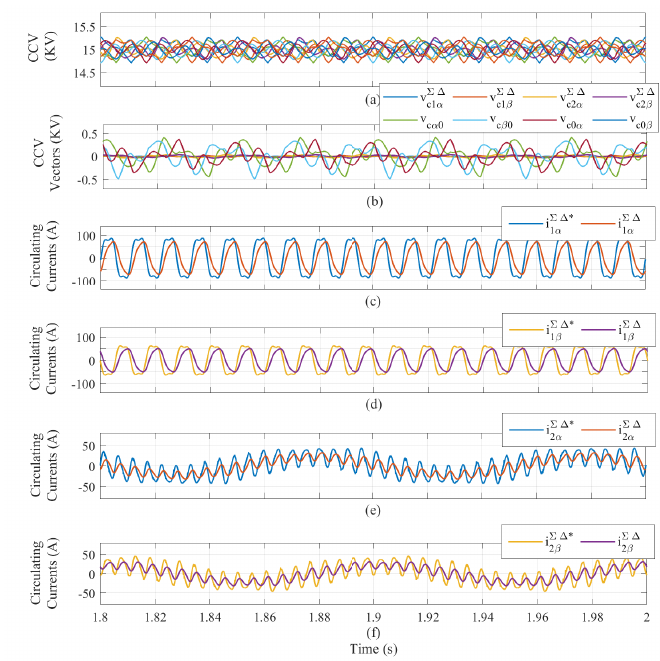
Figure 10. Test 1 results using proportional controllers. ( a ) CCVs. ( b ) CCV vectors in the Σ∆ double- αβ 0 frame. ( c – f ) Circulating current components in the Σ∆ double- αβ 0